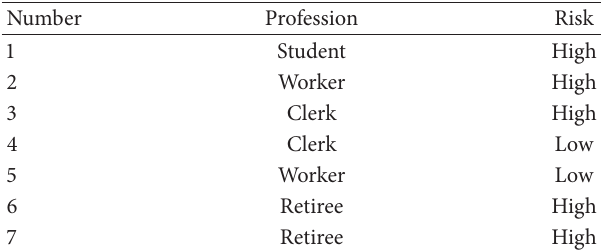
Table 1: Credit risk records of